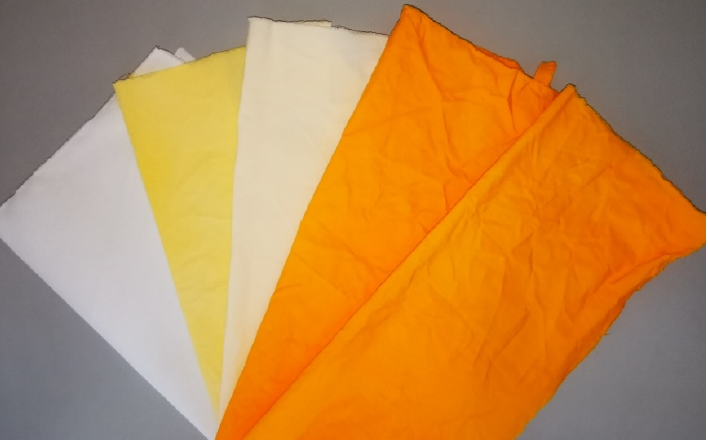
Figure 3. Samples before and after dyeing (from left to right: untreated, CO_D, CO_D_C, CT_CO_D and CT_CO_D_C.